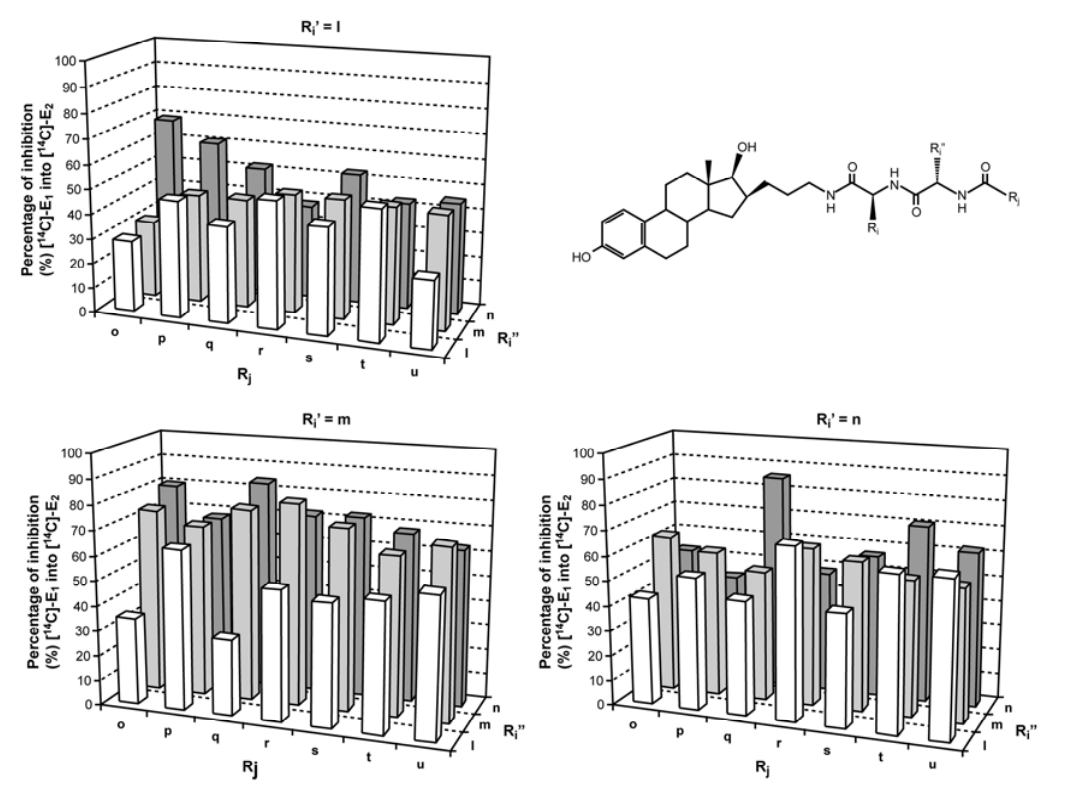
Figure 5. Inhibition of the transformation of [ 14 C]-E 293 cells overexpressing 17 β -HSD1 by E The letters l-u represent the residue (R experimental section for more details on this enzymatic